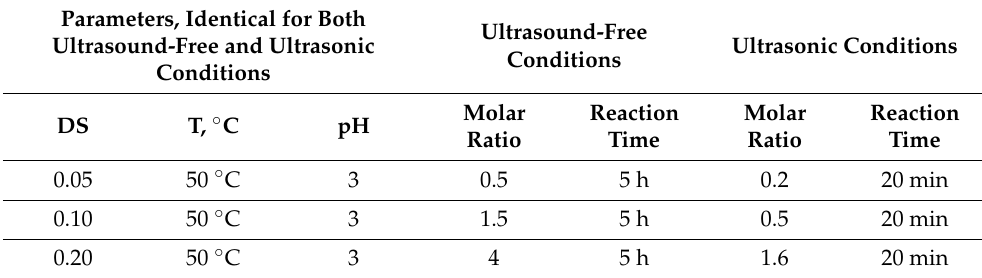
Table 1. Effect of ultrasonic irradiation on the synthesis of ciprofloxacin/chitosan conjugate without spacer (Scheme 1, system 1).